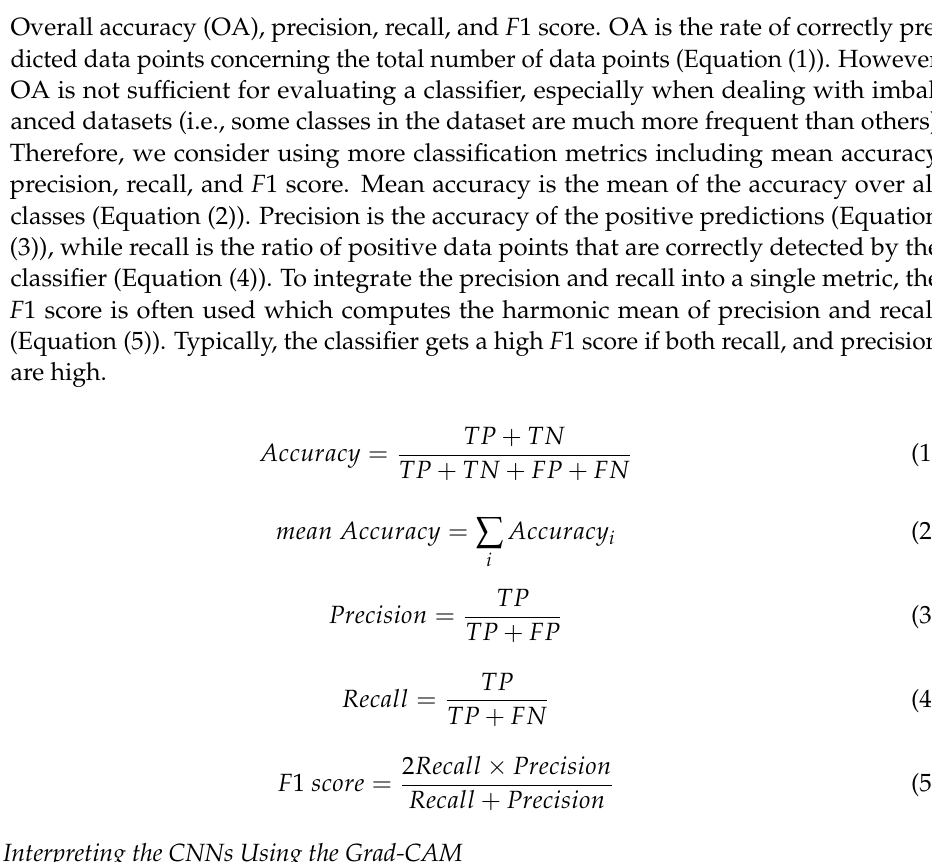
Figure 5. A confusion matrix table.